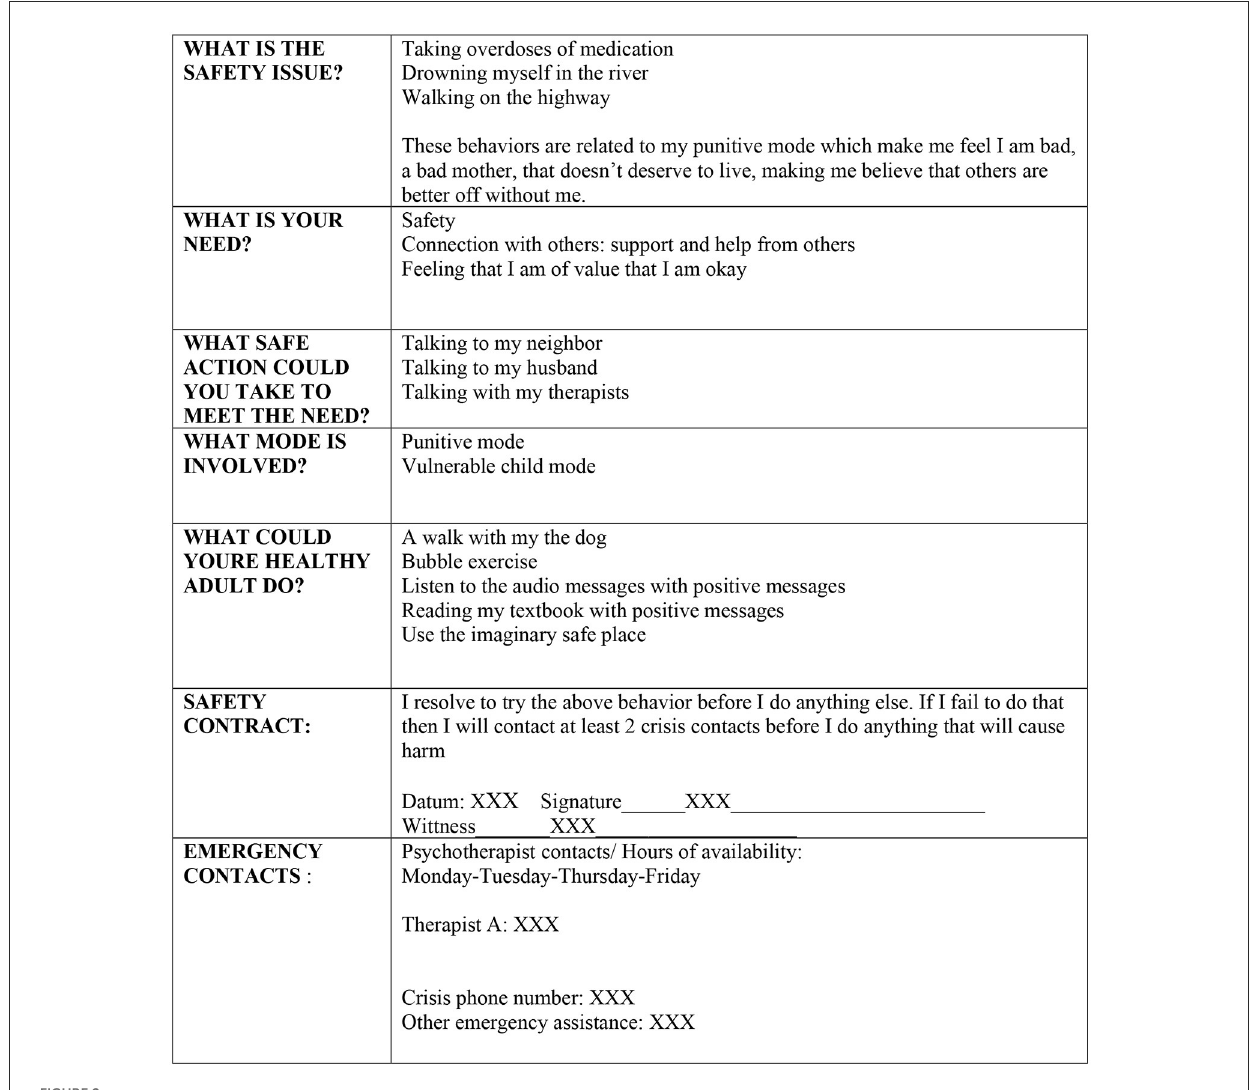
FIGURE2 Safety plan of the